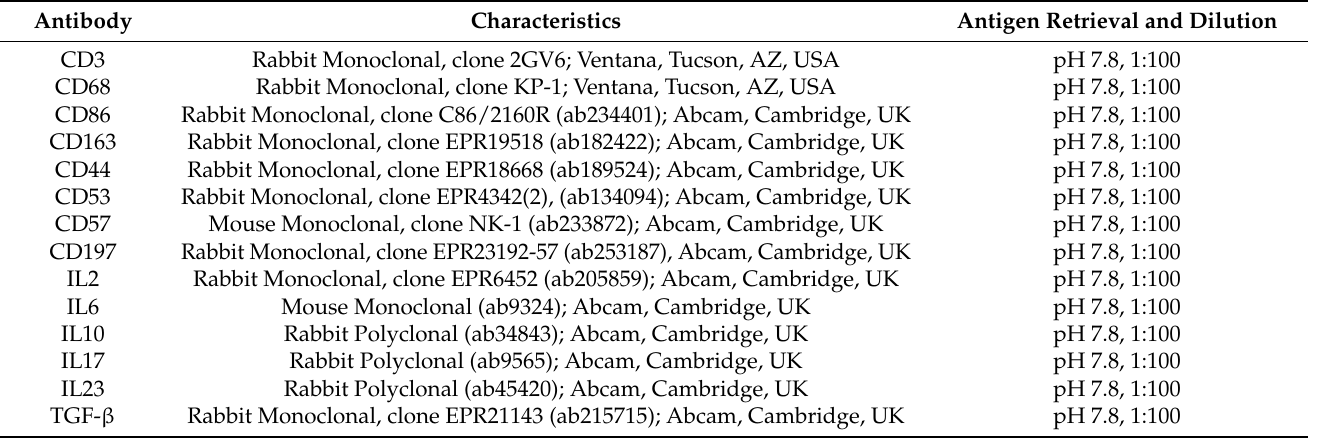
Table 5. Immunohistochemical antibodies for characterization of inflammation and mineralization markers expression Antibody Characteristics Antigen Retrieval and